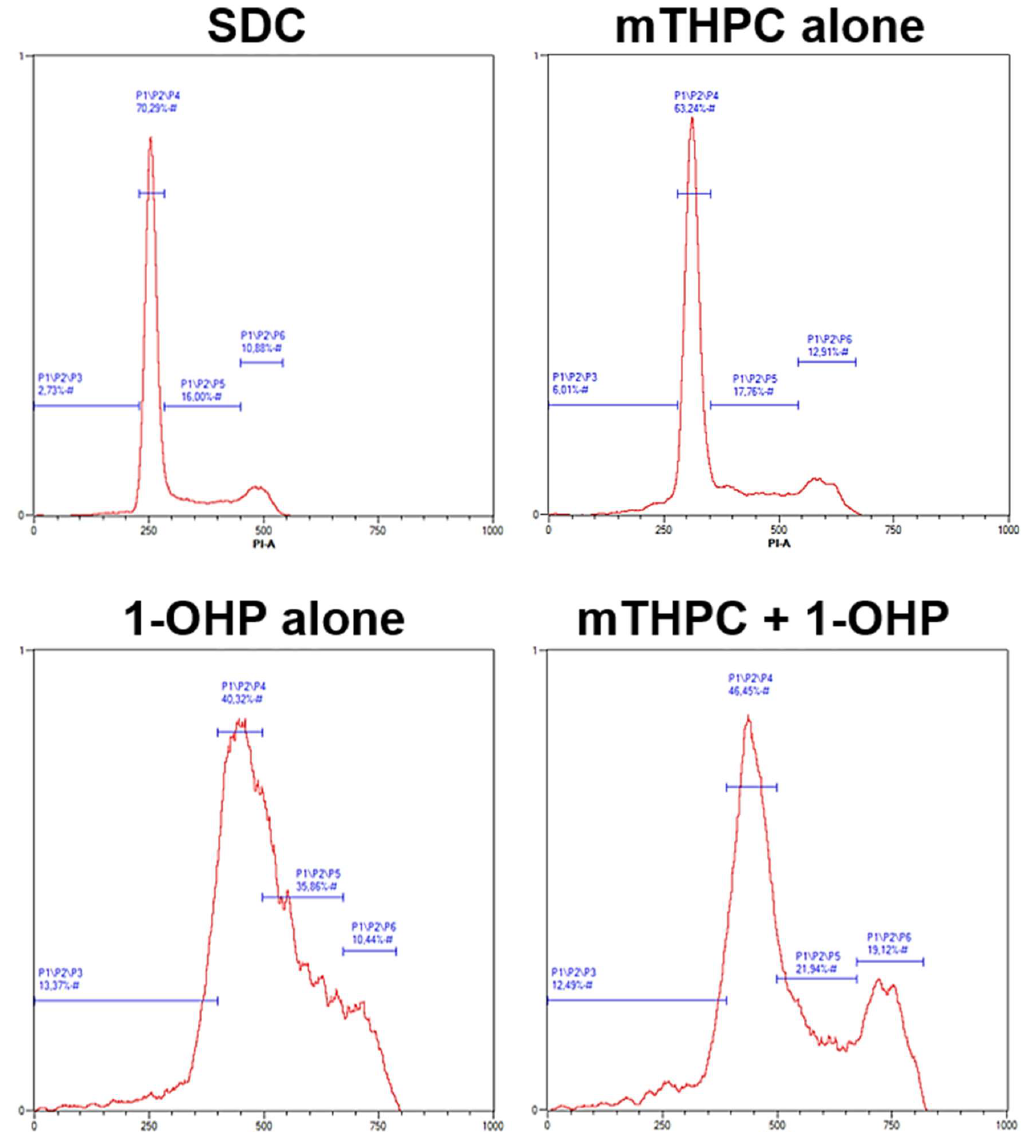
Figure A4. Representative histograms after flow cytometric analysis of cell cycle distribution in SISO cells. Cells were treated with a solvent dark control (SDC), mTHPC or 1-OHP alone, or a combination of mTHPC and 1-OHP prior to illumination with 1.8 J/cm 2 . Fixation and staining with PI were carried out 48 h after illumination. For each sample, 10,000 events were counted and gated for the single cell population (not shown) and cell were assigned to either subG 1 (fragmented DNA, apoptotic), G 0 /G 1 , S, or G 2 /M phase. The B3 channel ( λ Ex/Em = 488 nm/655–730 nm) of a MACS Quant flow cytometer. Data were analysed with the MACS Quantify Software.